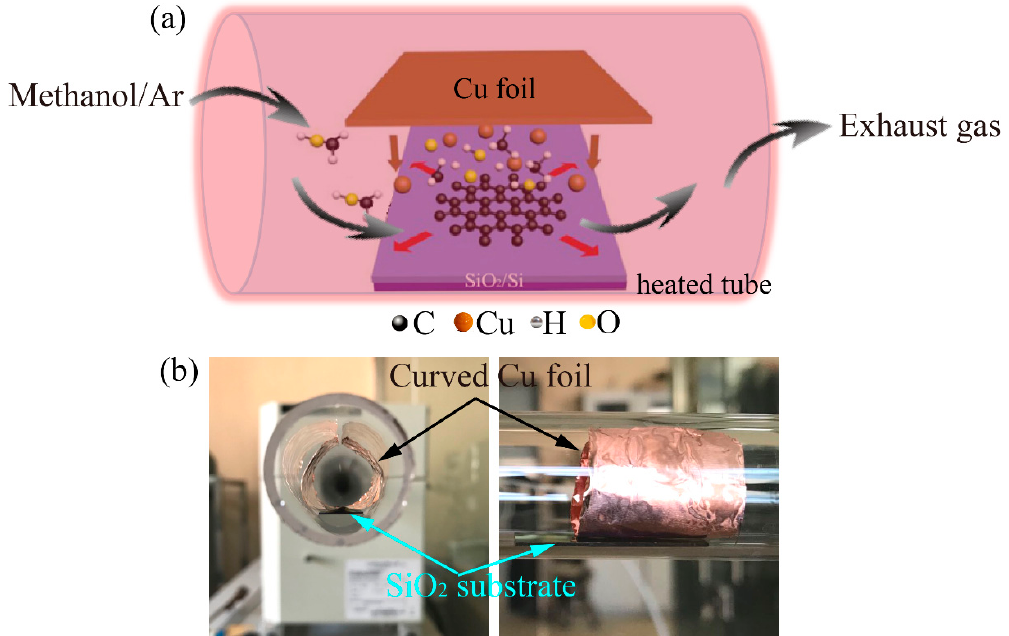
Figure 1. ( a ) Schematic illustration of the possible mechanism of the direct growth of graphene on the SiO 2 / Si substrate using methanol as the precursor. ( b ) Photography of curved suspended copper foil over the SiO 2 substrate.